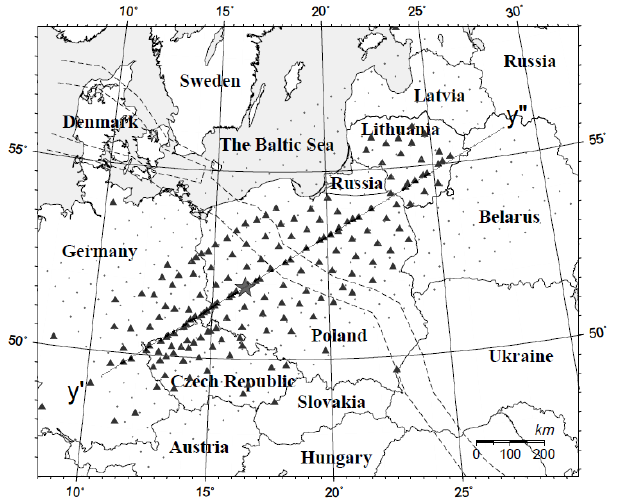
Figure 2. Seismic stations used in this study marked as triangles. Dots indicate nodes of the model grid. Star indicates origin of the local Cartesian coordinate system used. Dashed lines indicate the TESZ. Solid line y (cid:48) y (cid:48)(cid:48) marks the main PASSEQ transect at y = 0 in the local Cartesian coordinate system.